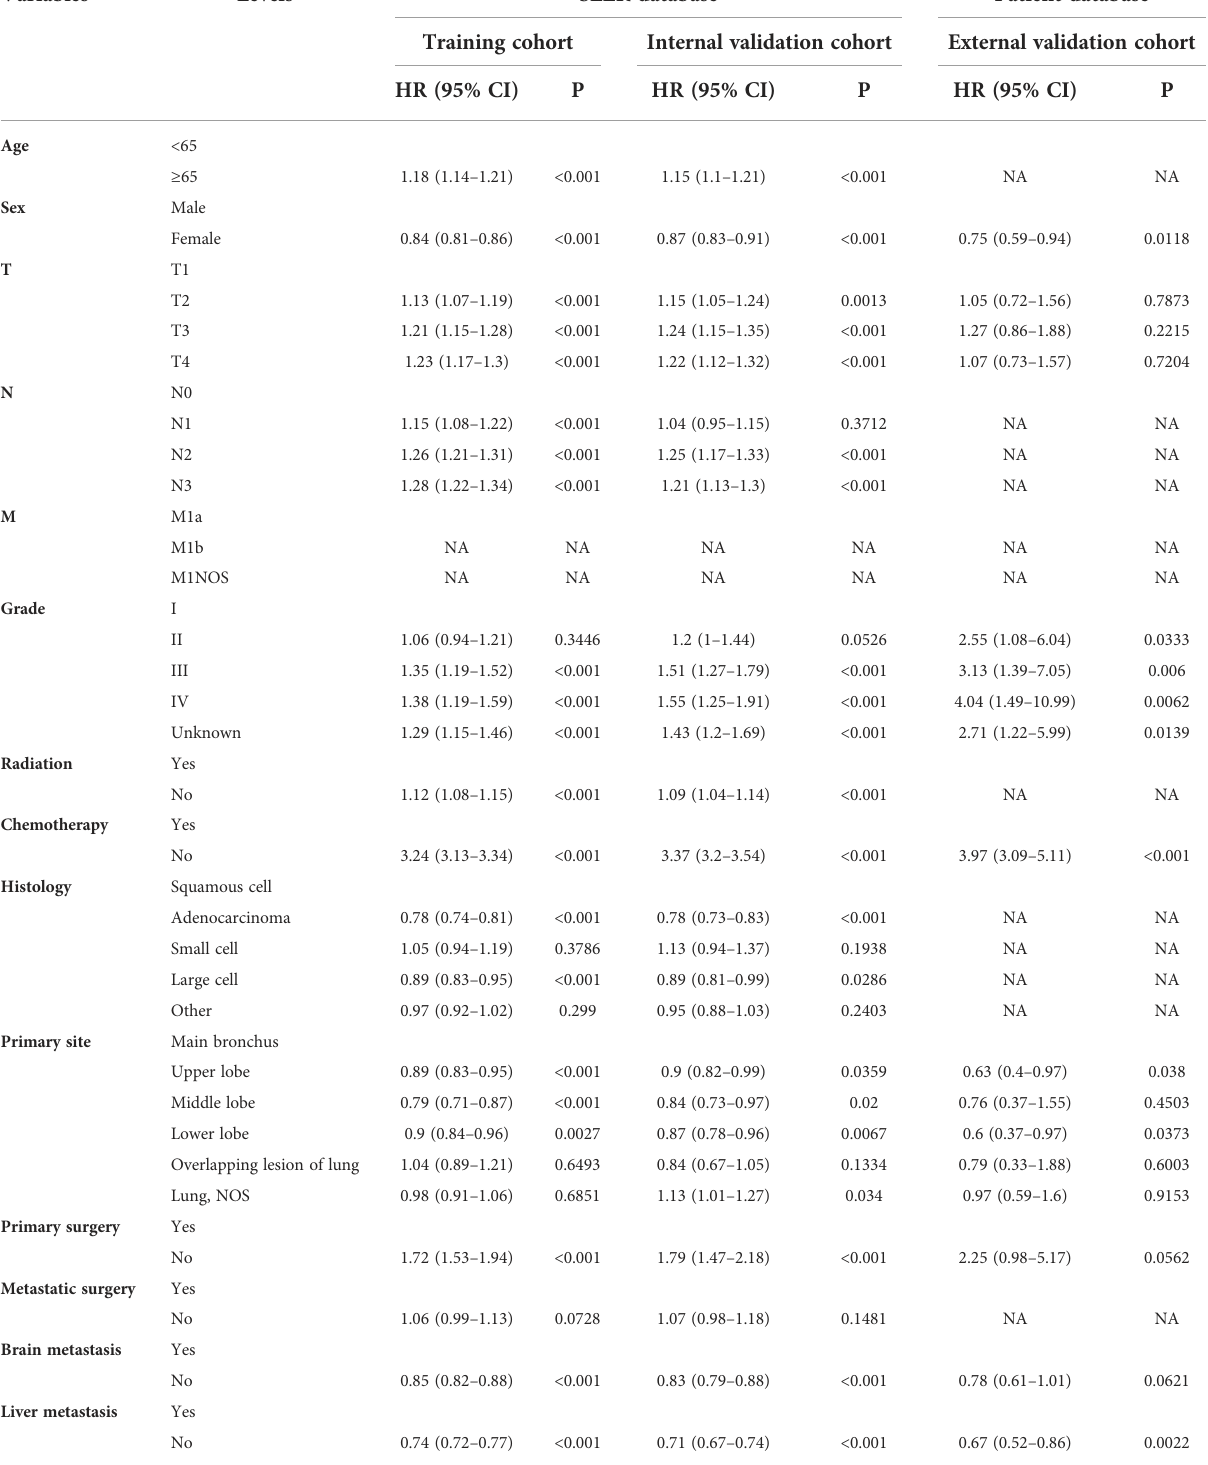
TABLE 3 Multivariate Cox regression model in the training, internal validation, and external validation cohorts of overall survival (OS) (N,